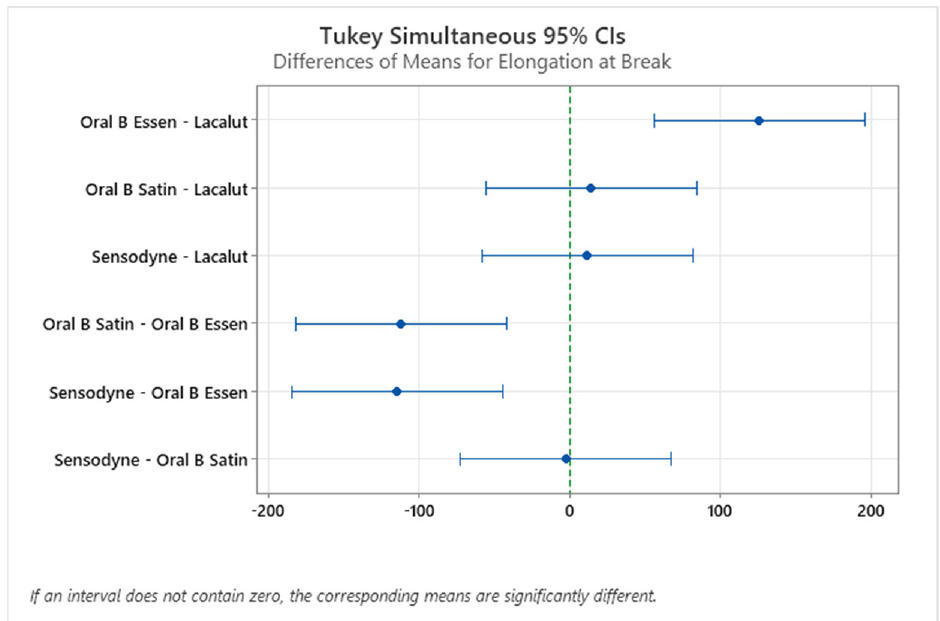
Figure 9. Differences of means for elongation at break, Tukey HSD test.